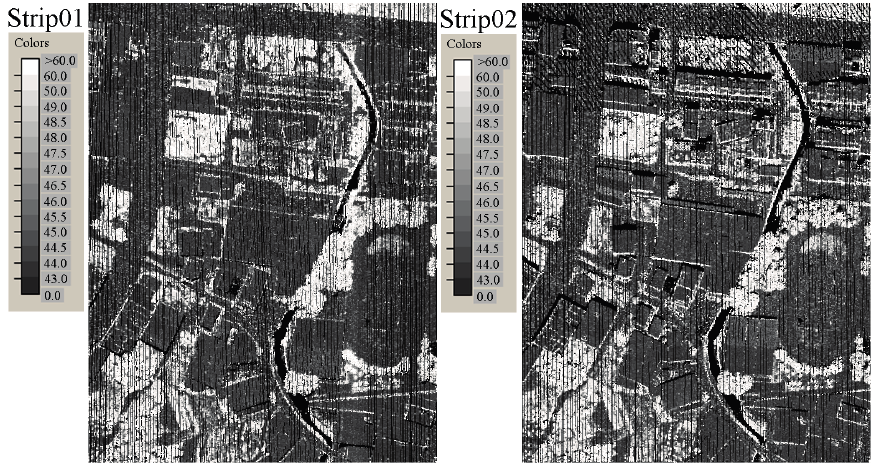
Figure 3. Amplitude point cloud for four overlapping strips. The area inside the yellow box shows where there are discrepancies due to the incidence